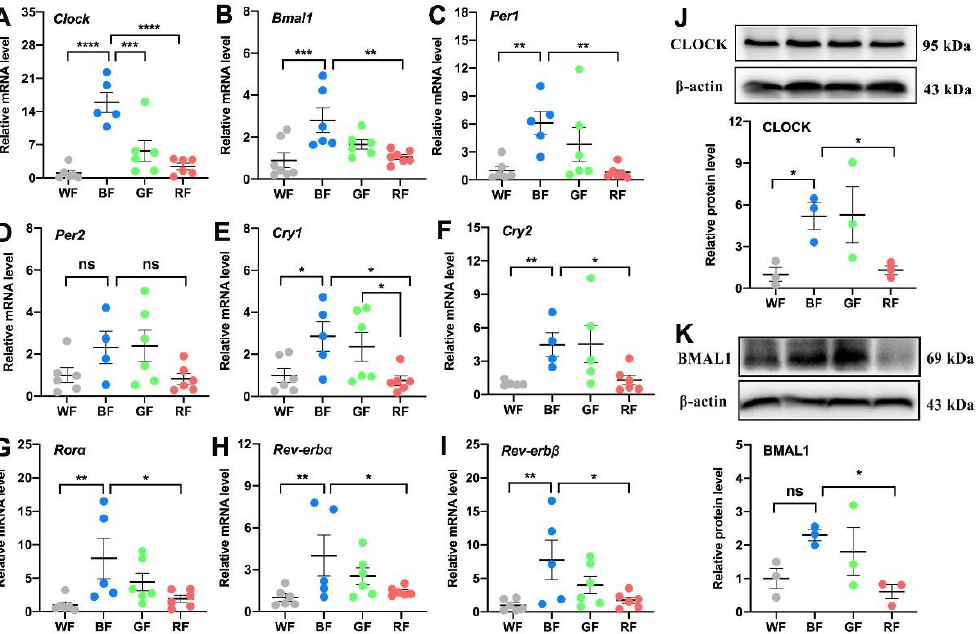
Figure 3. Influences of monochromatic light exposure on the expression of circadian genes in the WAT. ( A – I ) Relative mRNA expression levels of Clock, Bmal1, Per1, Per2, Cry1, Cry2, Ror α , Rev-erb α , and Rev-erb β in the Epi-WAT ( n = 6). ( J , K ) Relative protein expression levels of CLOCK and BMAL1 in the Epi-WAT ( n = 3). The results are presented as the means ± SEM. * p < 0.05, ** p < 0.01, *** p < 0.001, **** p < 0.0001.